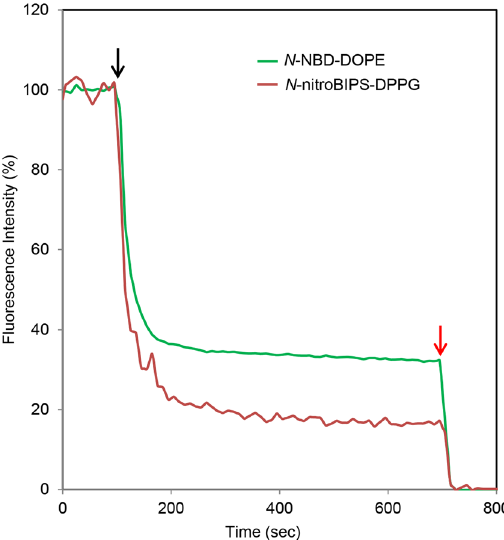
Figure 5. Quenching of outer leaflet N -NBD-DOPE (green line) and N -nitroBIPS-DPPG (red line). Time course of respective fluorescence emission in DOPC/ N -nitroBIPS-DPPG/ N -NBD-DOPE (98:2:2) liposomes as described in EXPERIMENTAL SECTION. Samples were irradiated with UV (340 nm) and blue green (480 nm, NBD) or green (543 nm, nitroBIPS) light alternating every 5 sec. Representative data of three independent experiments. Black arrow, addition of sodium dithionite; red arrow, addition of Triton